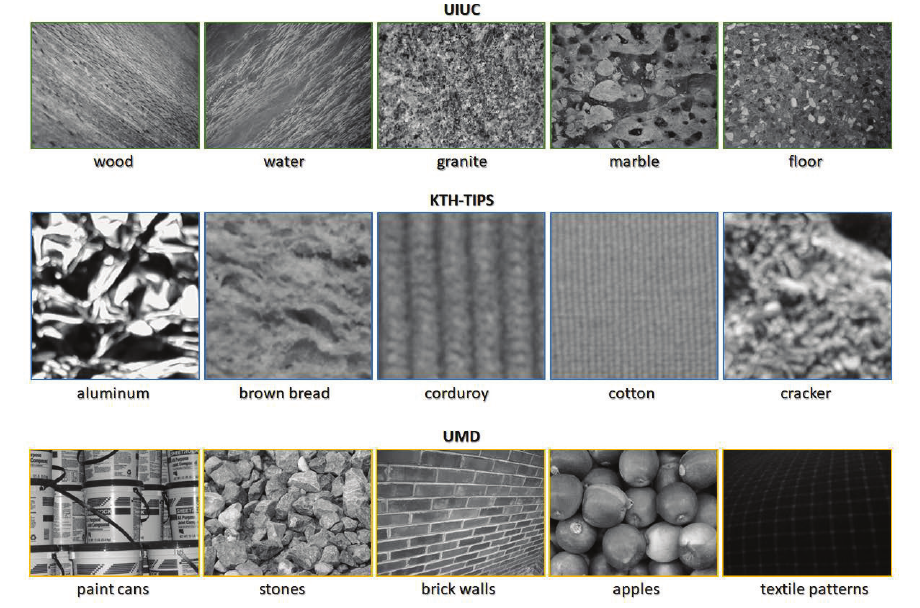
Figure 1. Samples extracted from UIUC, KTH-TIPS and UMD